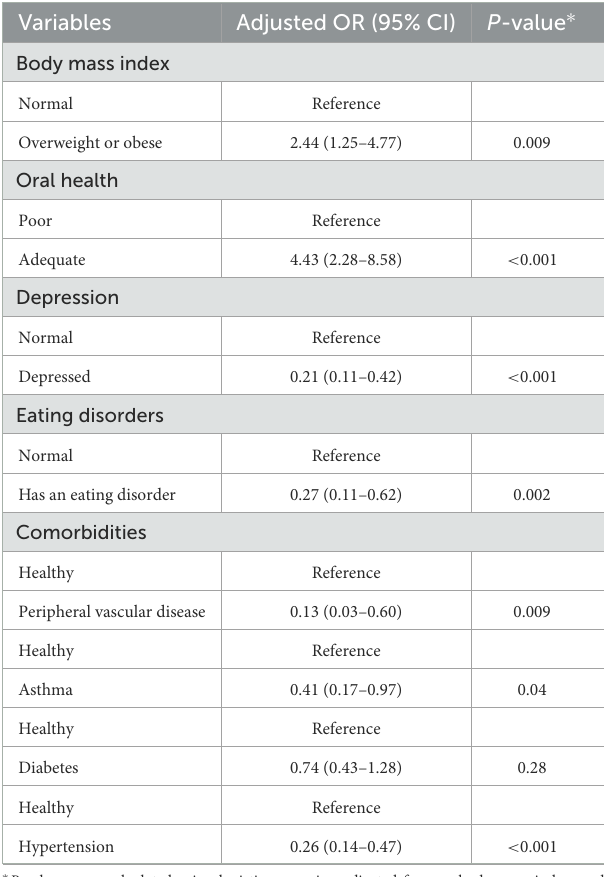
TABLE 4 Odds ratios for the risk of malnutrition among the